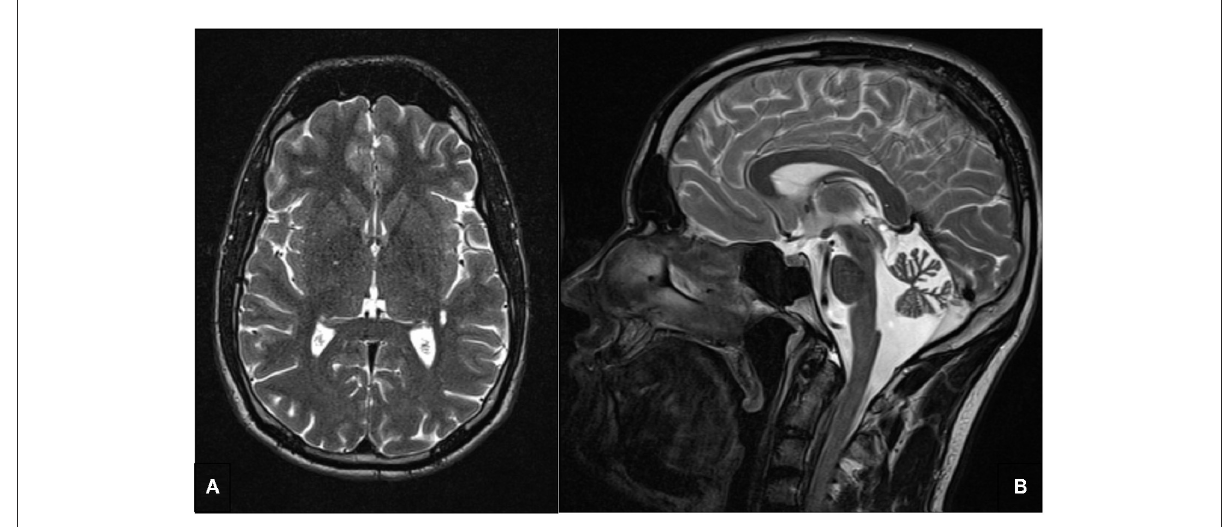
FIGURE2 T2 weighted cerebral magnetic resonance image. (A) No intraparenchymal signal alterations in the axial image. (B) Cerebellar atrophy, particularly of the vermis